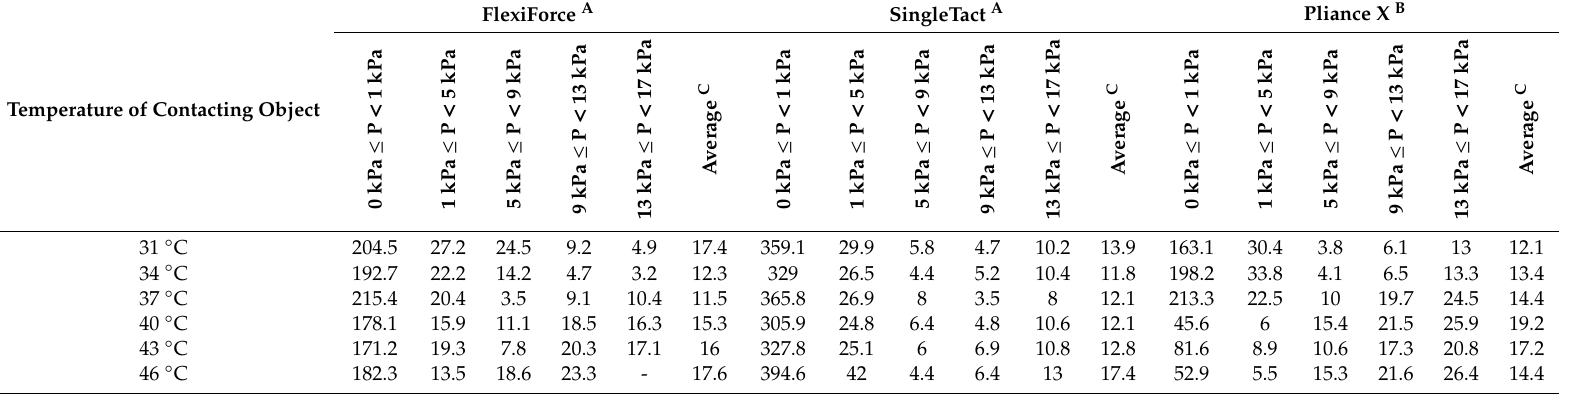
Table 3. Percentage error for di ff erent sensors when in contact with surface maintained at di ff erent temperatures with calibration at room temperature.